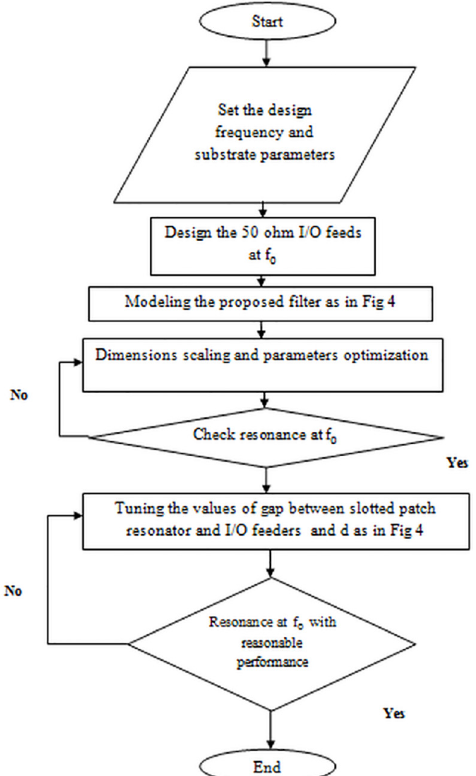
Fig 5. Optimization flowchart for proposed slotted patch filter